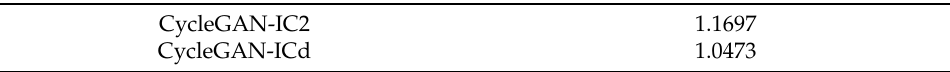
Figure 4. The box plots of ( a ) RMSE and ( b ) MCD for testing set MIR-QBSH-4 in singing to viola. Table 6. The average RMSE for MIR-QBSH-4 in singing to viola. Table 6. The average RMSE for MIR-QBSH-4 in singing to viola.